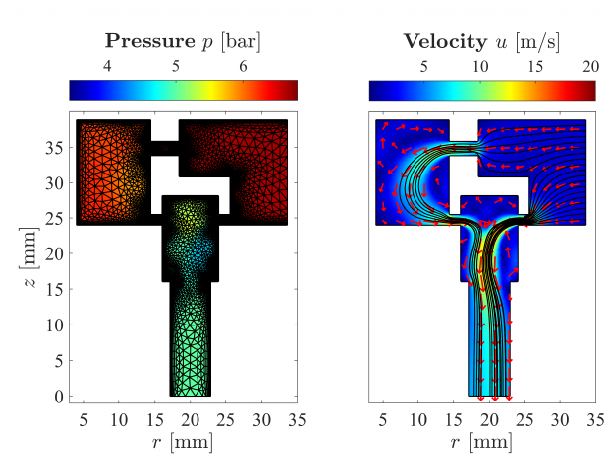
Figure 9: Pressure and velocity distributions for a flow rate of -300 L/min obtained using the k- (cid:15) model.